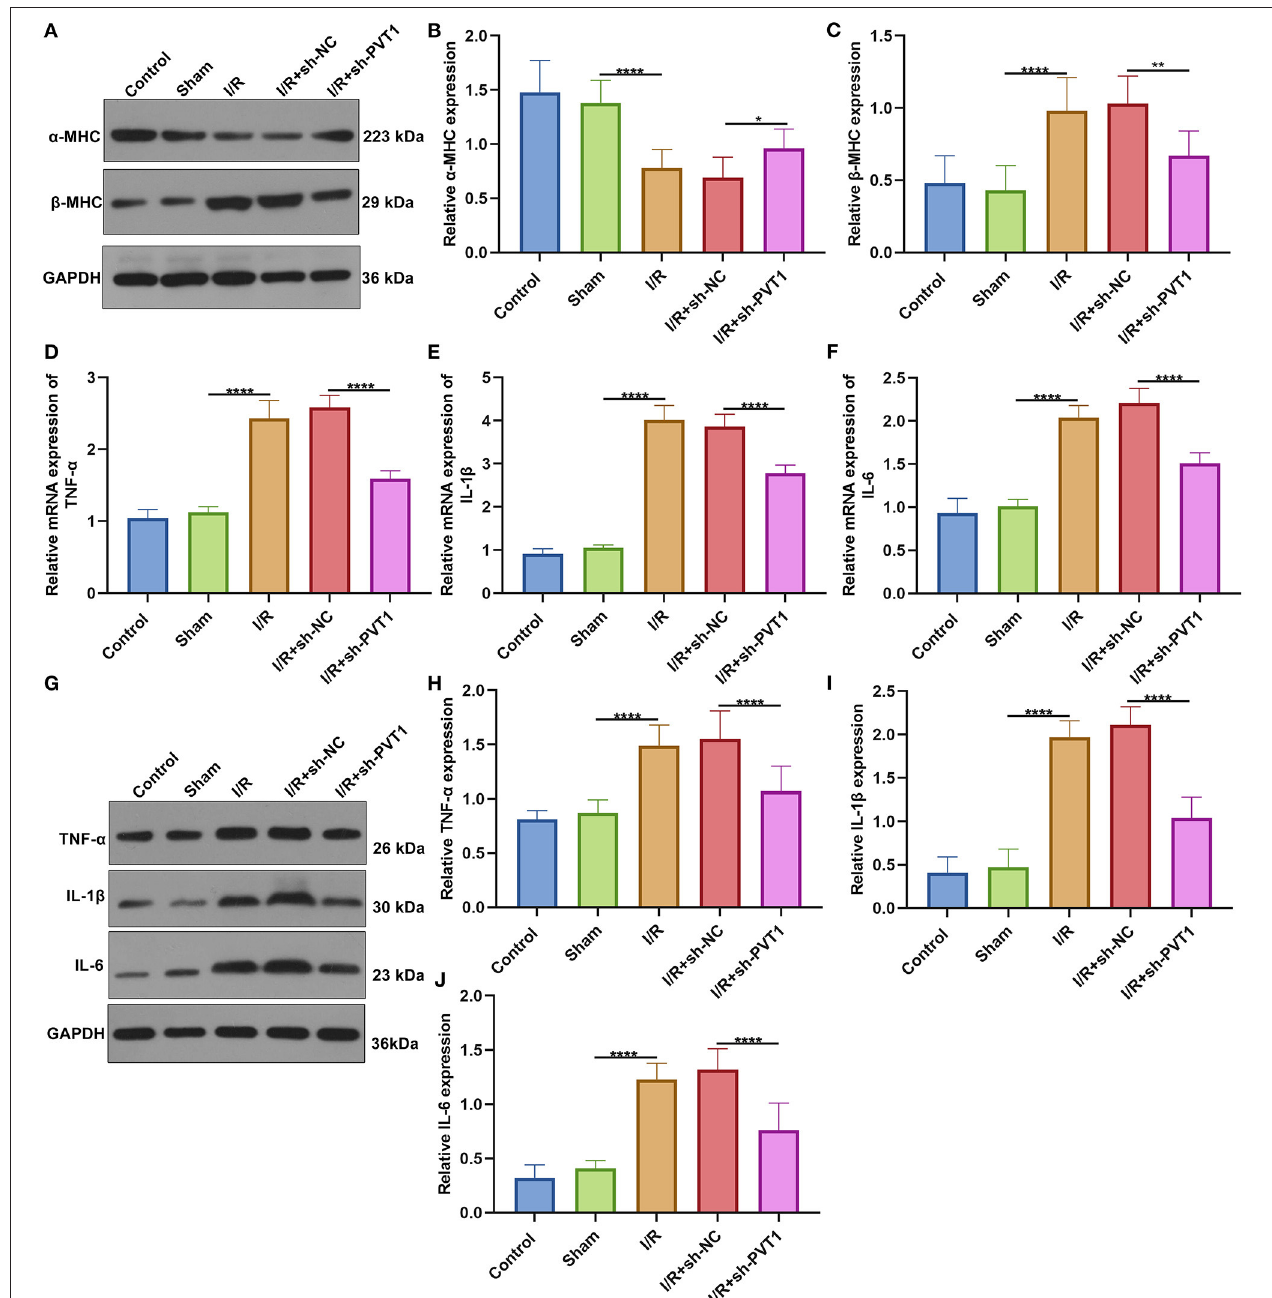
FIGURE 2 | LncRNA PVT1 knockdown ameliorates cardiac function and cytokine release in myocardial I/R mice. (A–C) Western blot of the expression of (B) α -MHC and (C) β -MHC in myocardial tissues of control, sham, I/R, I/R + sh-NC, and I/R + sh-PVT1 groups. Mice in the I/R + sh-NC and I/R + sh-PVT1 groups were injected by 10 µ L sh-NC or sh-PVT1 via Lipofectamine 2000 reagent. After 48h, myocardial I/R model was constructed. No treatment was done for mice in the control group. The chest of mice in the sham operation group was only opened, but was threaded the corresponding part without ligating the LAD. There were 10 mice in